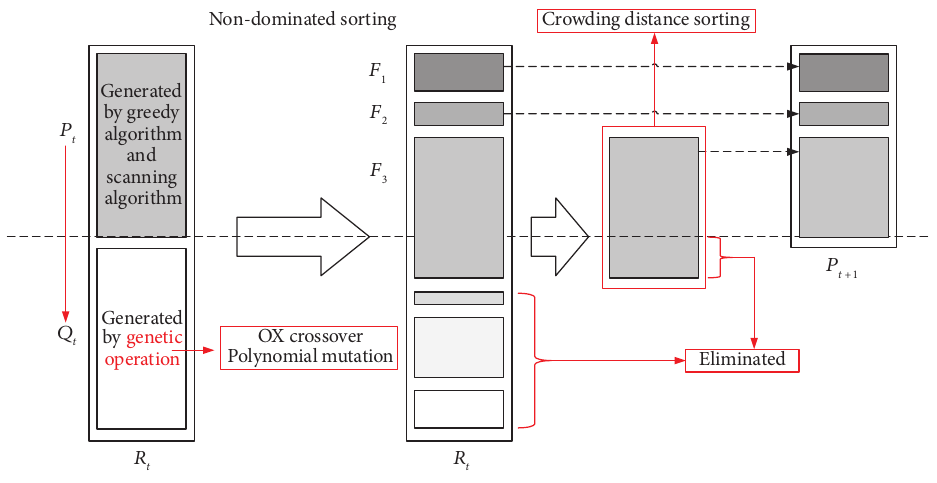
Figure 3: Major procedures of the Im-NSGA-II.